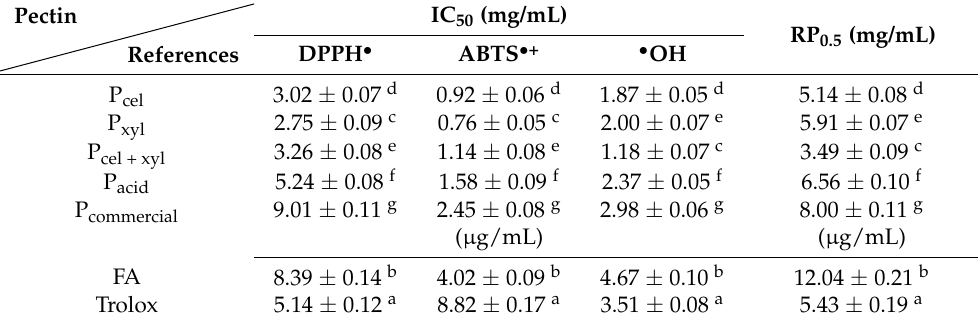
Table 2. Antioxidant activity of acid and enzymatically extracted apple pectins.